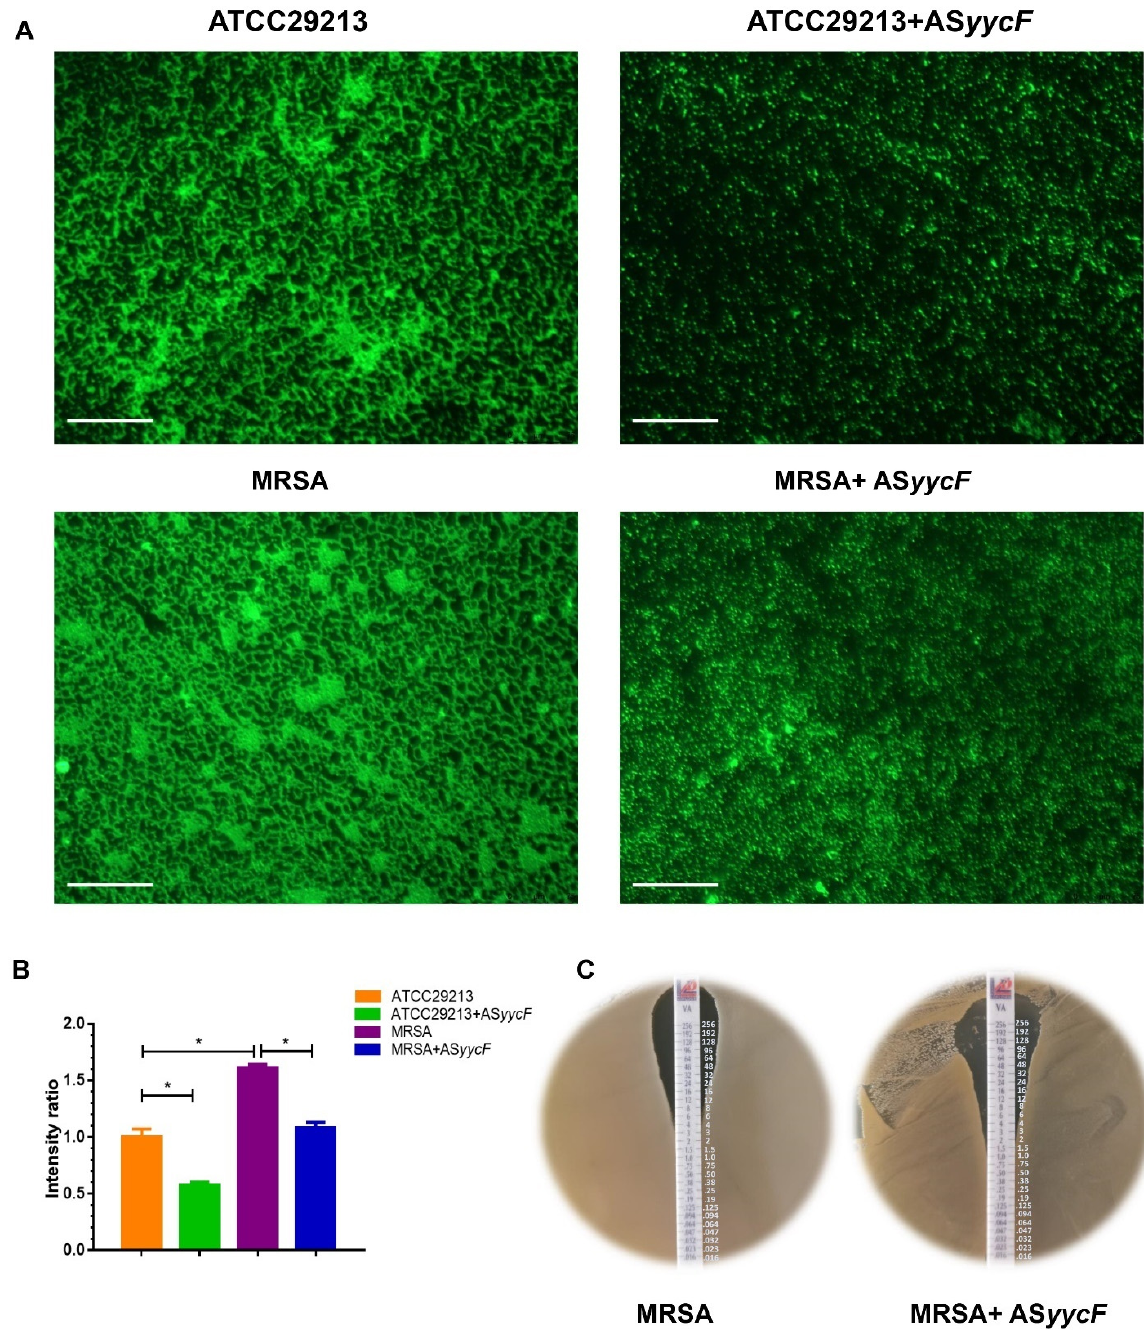
Figure 3. Effect of biofilm formation on antibiotics sensitivity. ( A ) Intensity of fluorescence for S. aureus ATCC29213, and MRSA strains after AS yycF overexpression (scale bar = 100 µ m). ( B ) Intensity of fluorescence comparisons and the intensities of S. aureus ATCC29213 were measured as reference ( n = 10, * p < 0.05). ( C ) E-test for the sensitivity of MRSA to vancomycin.